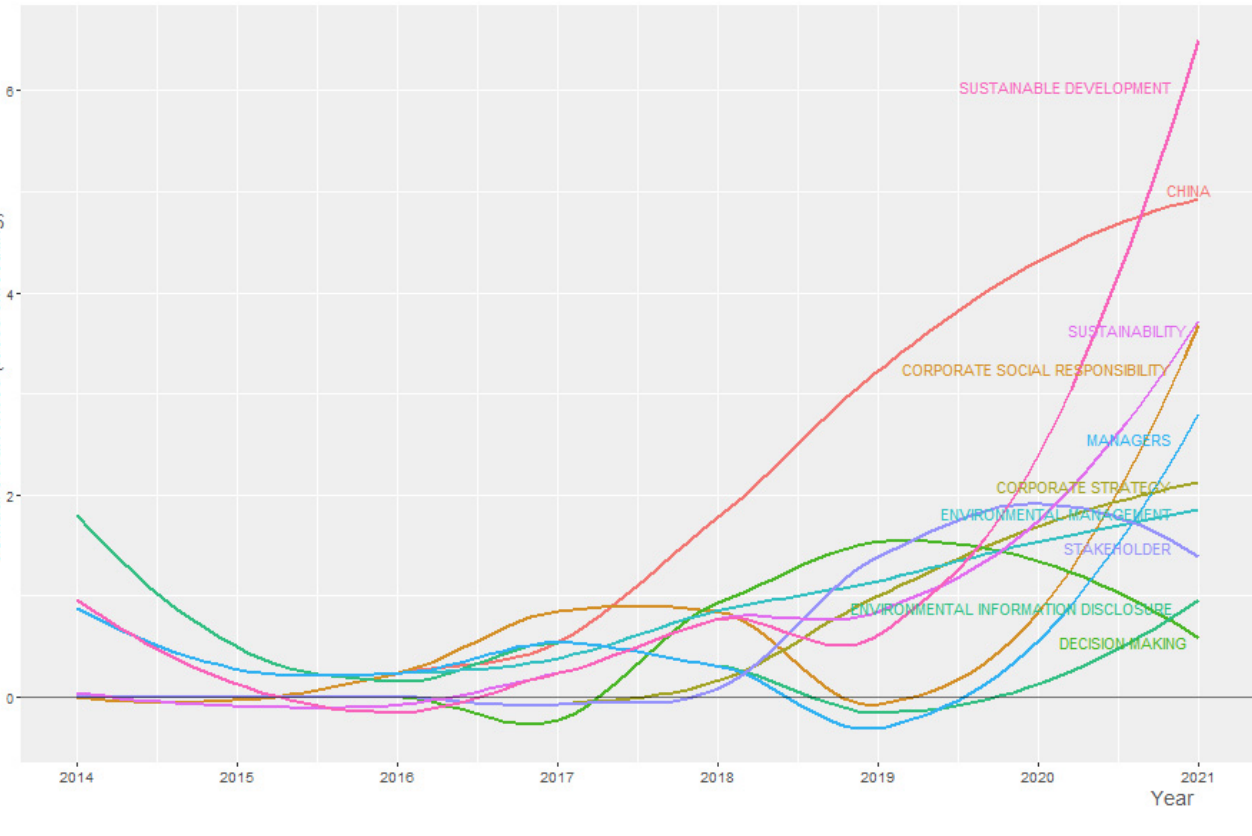
Figure 6. Word Growth Overtime. Table 3. Top countries in terms of publications and